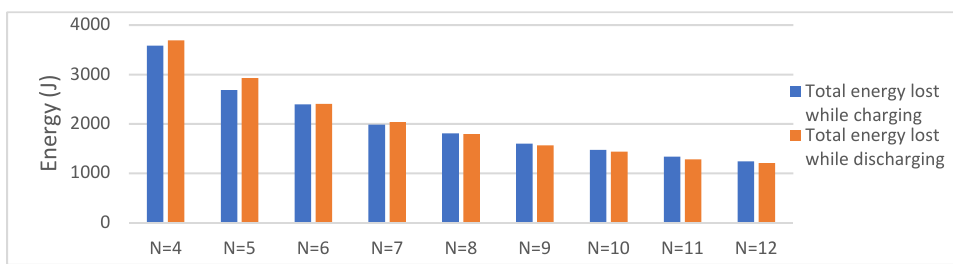
Figure 16. Amounts of energy lost during the charging of the SC circuit during the operations of the individual duty cycles at different numbers of phases.